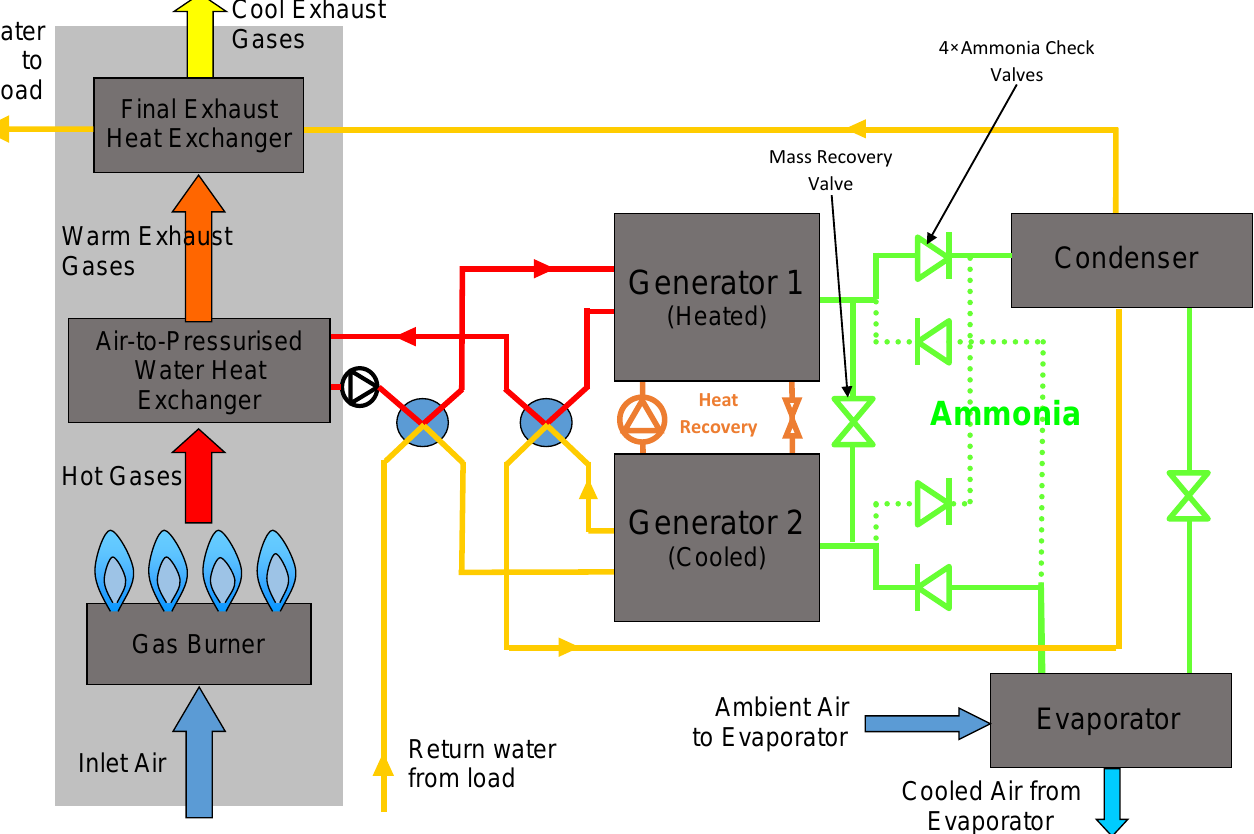
Figure 1. Schematic diagram illustrating the two-bed gas heat pump concept with heat and mass recovery (shown in the configuration for the first stage of the cycle).